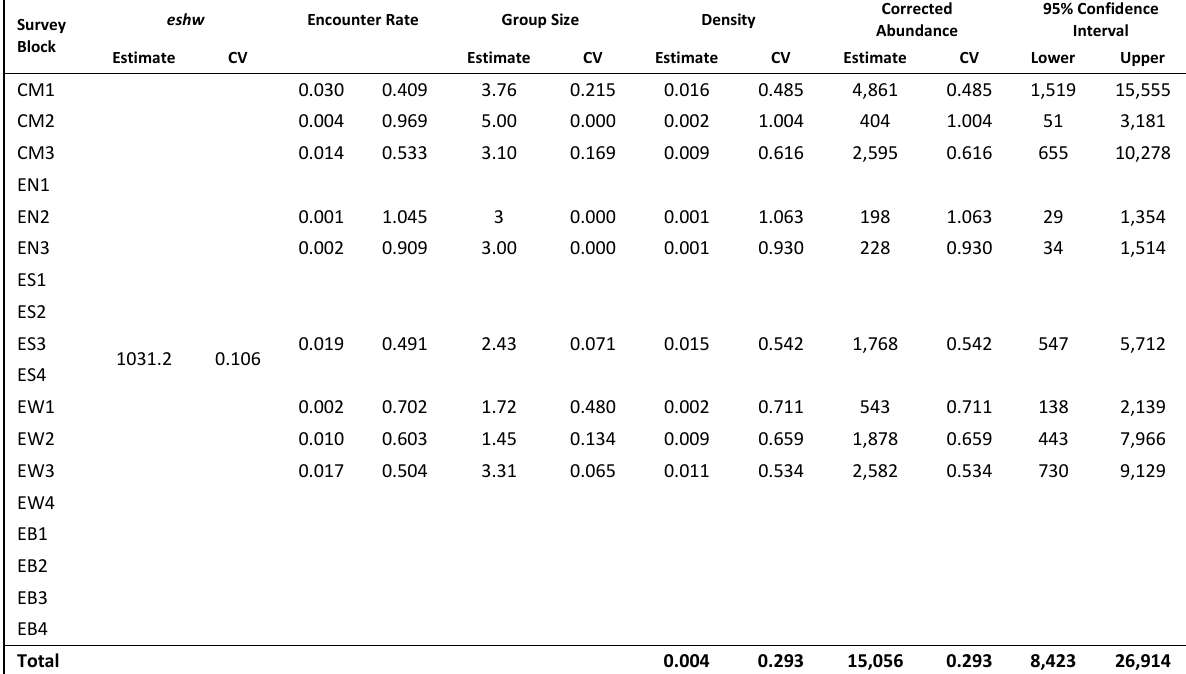
Table 9. Estimated density and abundance of killer whales. The eshw (effective search half width (m)) was estimated for the entire study area. Encounter rate, group size, density, abundance, and upper and lower confidence limits were estimated by block and corrected for perception bias, with the estimated p (0).